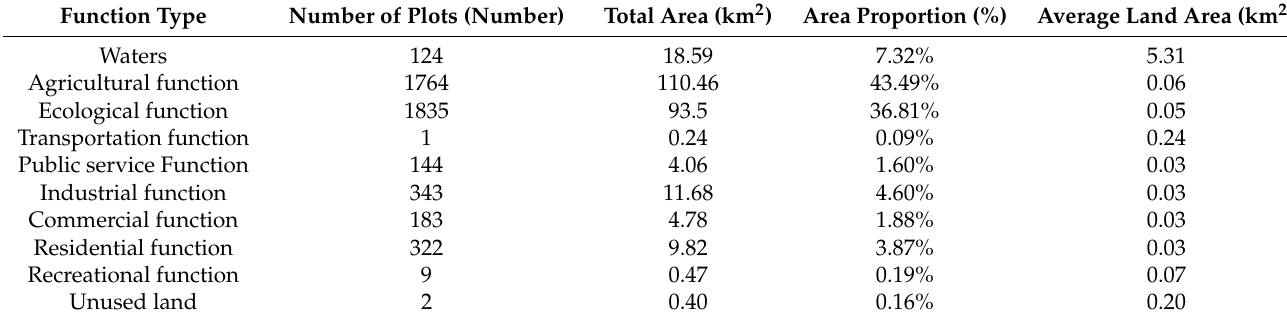
Table 3. Area statistics of each function type.